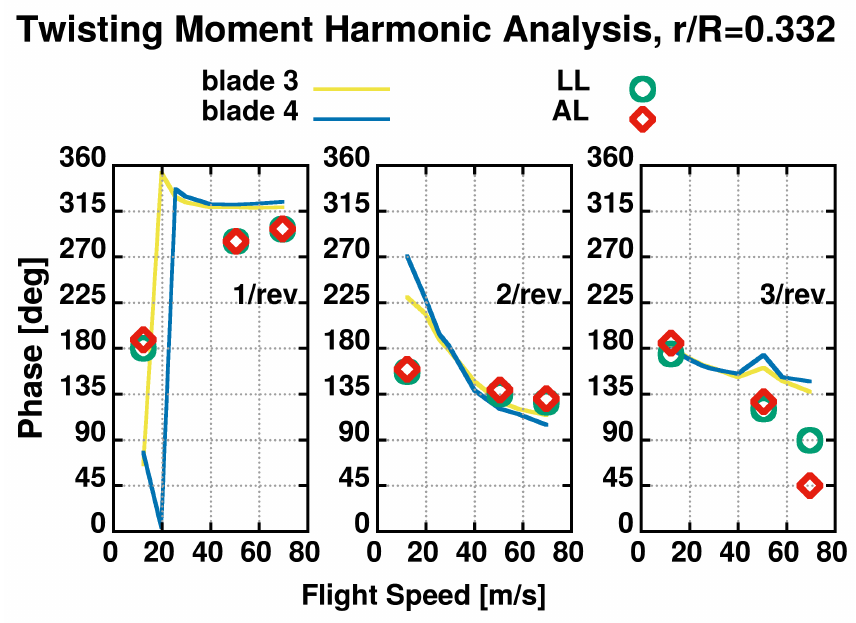
Figure 47. Harmonic analysis of Twisting moment. Phase of frequencies with the highest energy